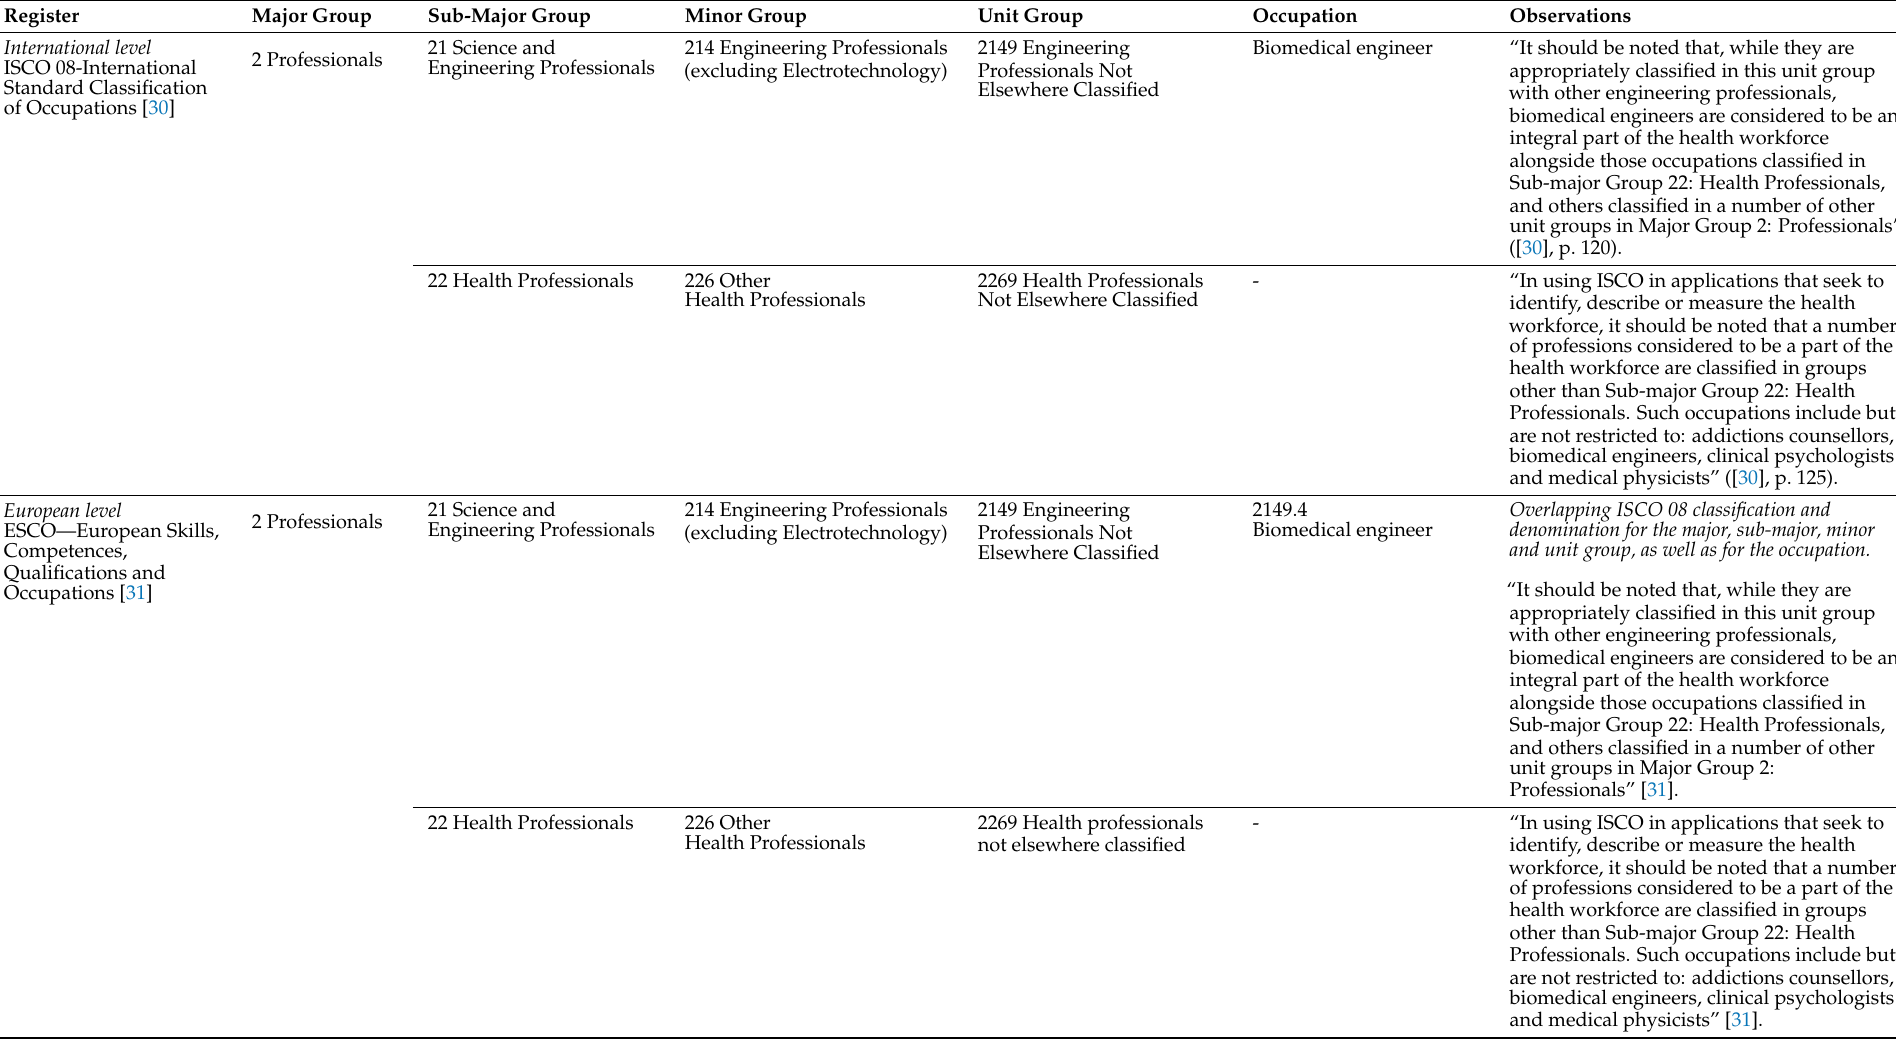
Table 5. Author’s comparative analysis of the ISCO-08, ESCO and COR of the biomedical engineer